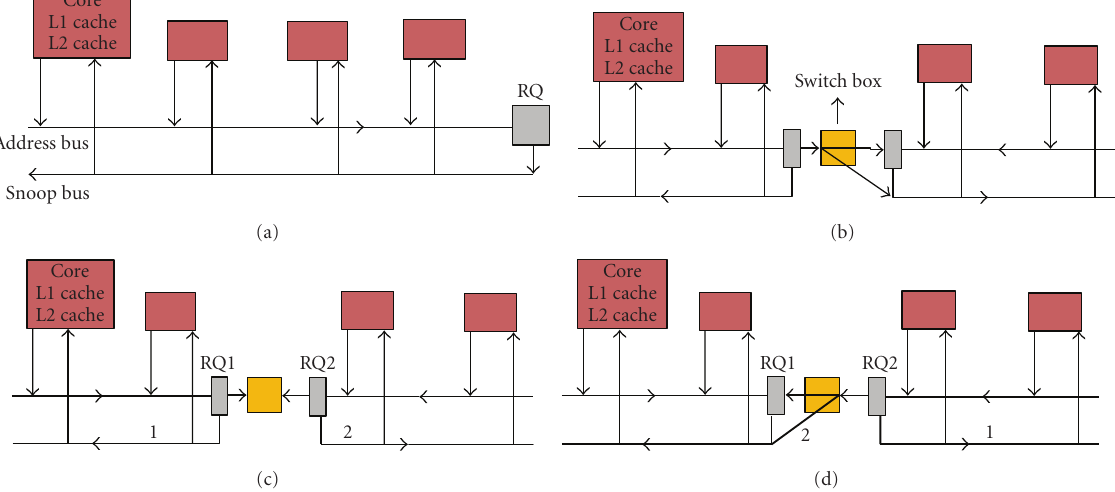
Figure 6: Examples of proposed interconnects; (a) High-level view of baseline shared-bus interconnect; (b) High-level view of proposed reconfigurable shared-bus interconnect; (c) Shared-bus interconnect depicting region isolation; (d) Shared-bus interconnects depicting interconnect